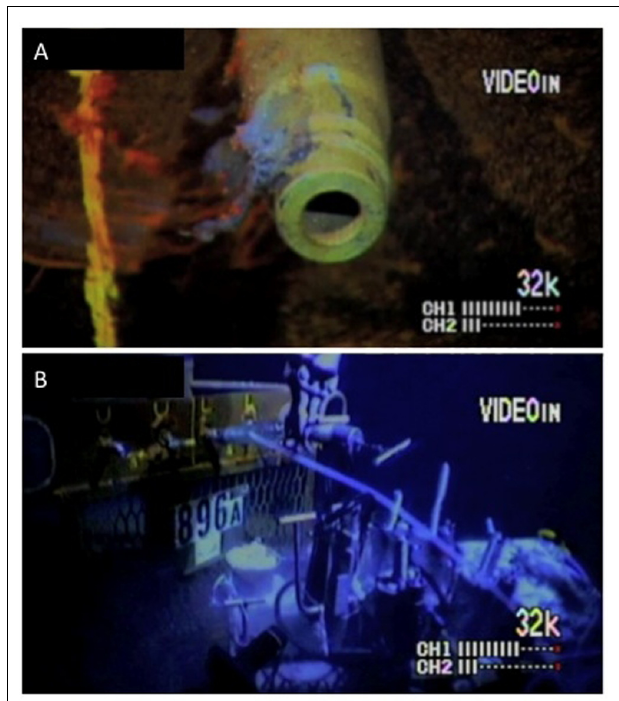
FIGURE 2 | Microbial mat and fluid sampling at ODP Hole 896A made from still images captured during Alvin operations. (A) The L port with attached biofilm, removed with the first scrubber and sequenced as “mat” sample; (B) water sampling (the material used here) by tube coupling to the L